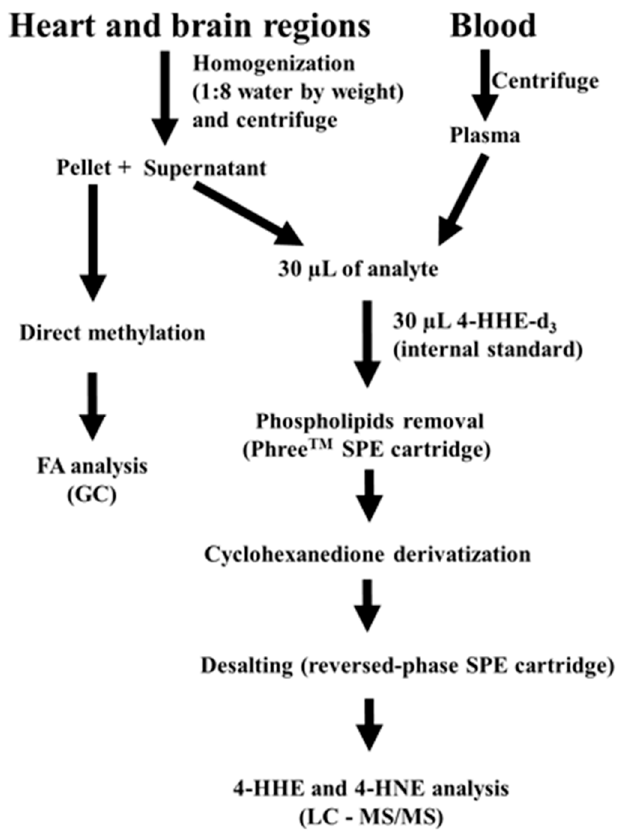
Figure 7. Workflow for analysis of FA, 4-HHE and 4-HNE in the offspring brain, heart and plasma.